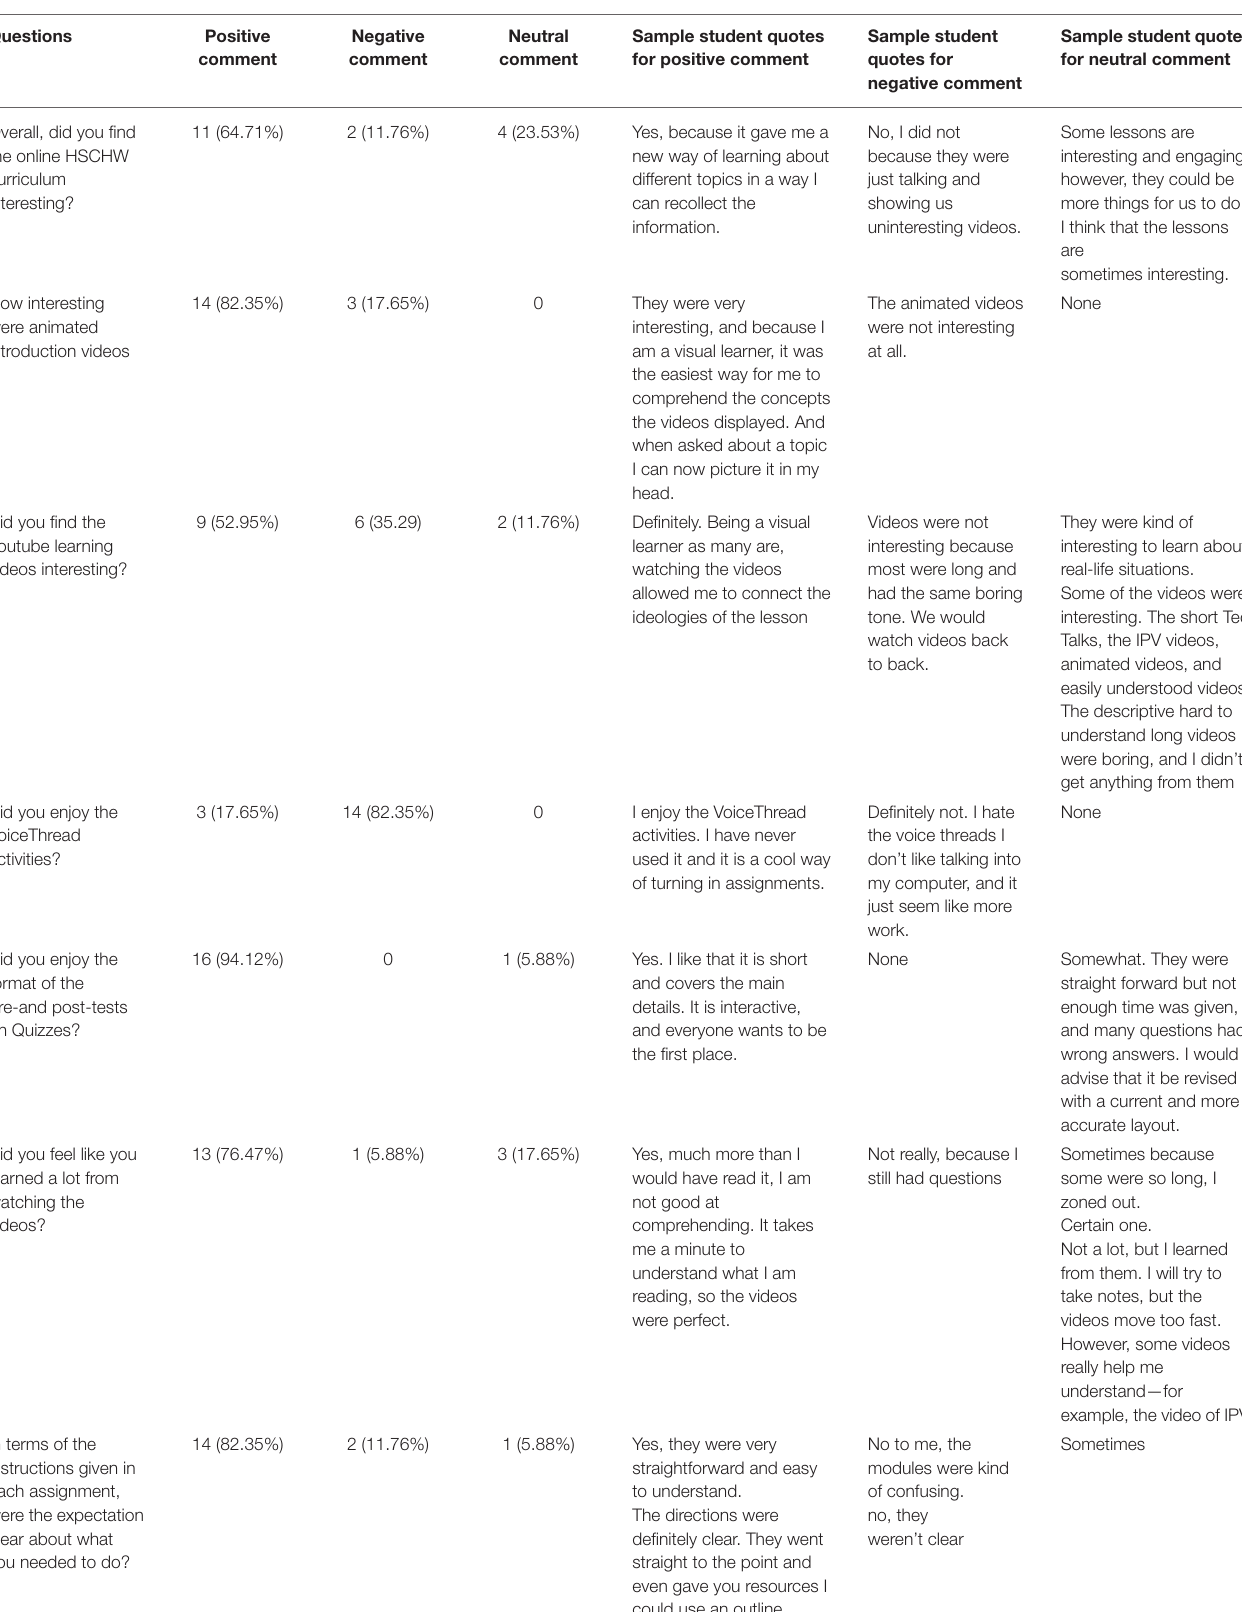
TABLE 1 | Student evaluation of interestingness of the online HSCHW